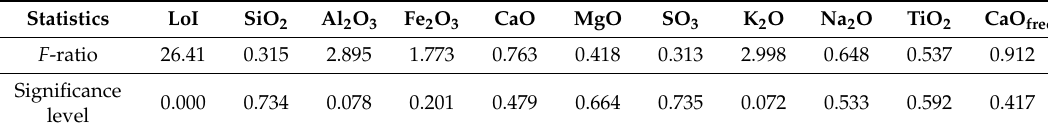
Table 2. ANOVA involving the influence of the source of CFA (boilers (B1, B2) and retention tank (T)) on its composition.